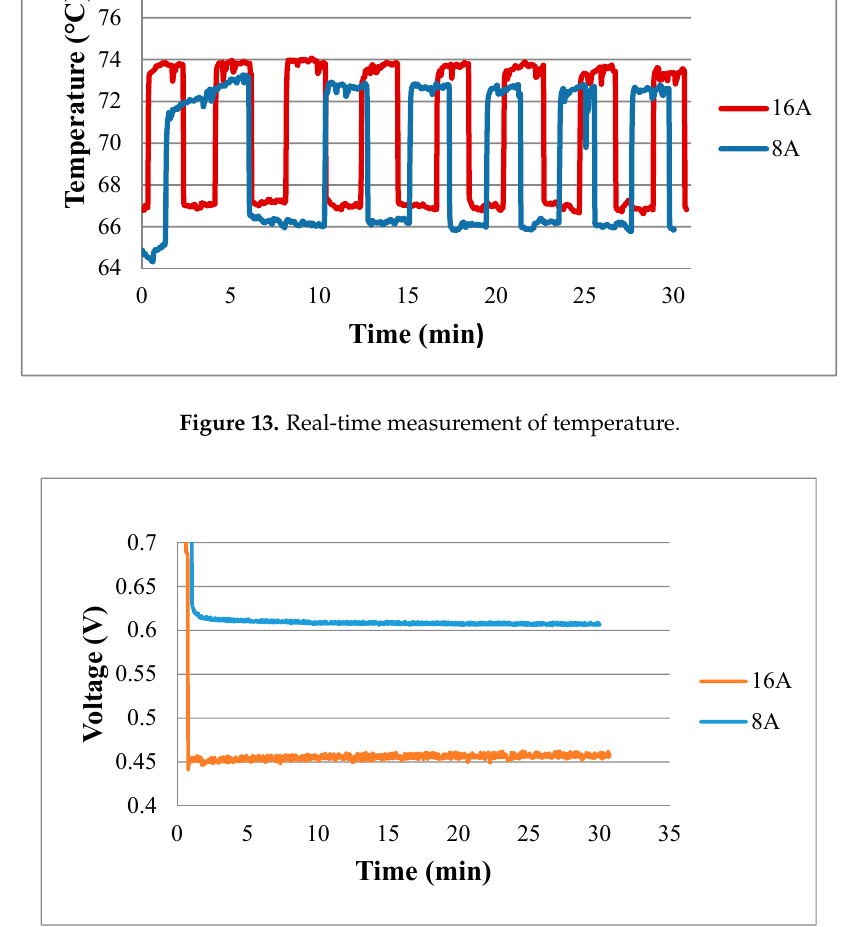
Figure 14. Real-time measurement of voltage.